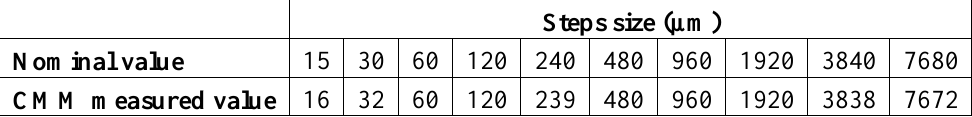
Table 2. Nominal and actual step size of the ―set of steps‖ test object shown in Figure